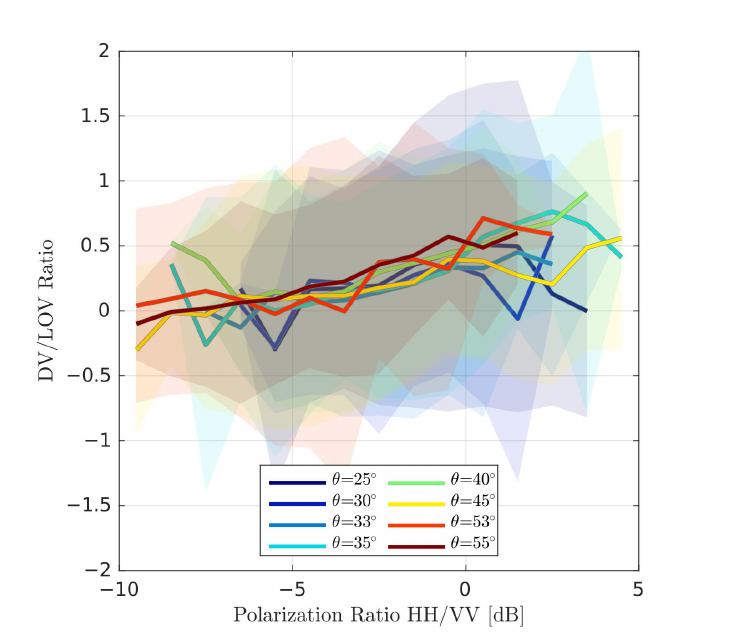
Figure 8. The Doppler velocity (DV) normalized by the line-of-sight projection of the breaker optical velocity (LOV), DV/LOV, versus the polarization ratio, HH/VV. The data are from the “instant” dataset and bin-averaged in 1 dB steps along the PR axis. Solid lines are the binned mean, and shaded areas are the corresponding standard deviation. Plots are color-coded versus the incidence